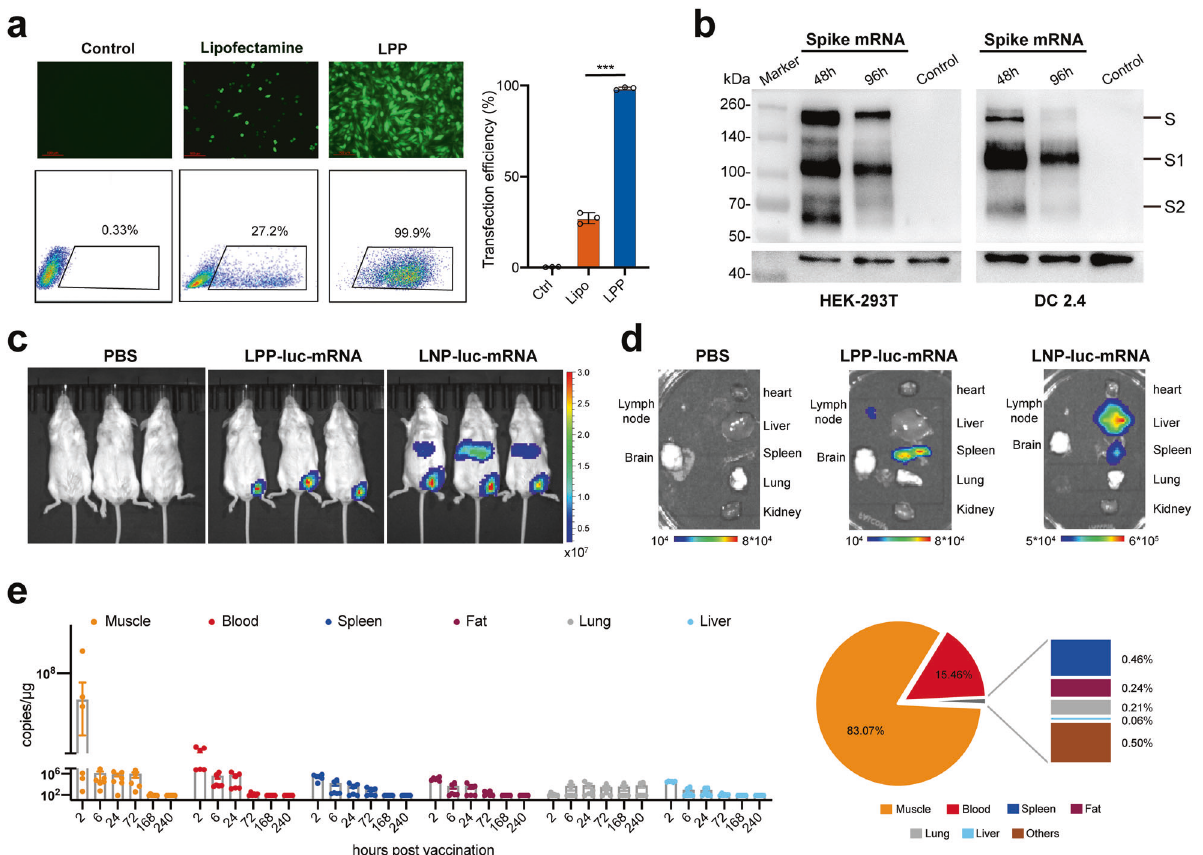
Fig. 2 Transfection ef fi ciency and biodistribution of LPP-mRNA. a eGFP-mRNA was transfected into DC2.4 cells using LPP or lipofectamine. Cells were harvested after 24 h of incubation. eGFP expression was visualized using fl uorescent microscope (upper panel) and quanti fi ed using fl ow cytometry (lower panel). b S protein expression from mRNA used for SW0123 preparation. mRNA encoding the S protein was transfected into HEK-293T and DC2.4 immortalized cells. Cells were harvested 48 and 96 h later, and S protein levels in cell lysate were detected with western blot. c Comparison of biodistribution between LPP/mRNA and LNP/mRNA. BALB/c mice were administrated intramuscularly (i.m.) with LPP or LNP encapsulated with luciferase-mRNA. Bioluminescence was measured 6 h later in a Xenogen IVIS-200 imaging system. d Mice were euthanized, and bioluminescent intensity in major organs were detected with a Xenogen IVIS-200 imaging system. e Biodistribution of SW0123 in BALB/c mice. BALB/c mice were i.m. injected with SW0123 at a single dose of 1.5 mg/kg. Major organs or tissues were collected at different time points following vaccination ( n = 6 mice each time point). mRNA concentration was determined with real-time qPCR using probes speci fi c for the mRNA component of SW0123 (left panel). Area under curve (AUC) representing accumulative distribution of SW0123 in each specimen is shown (right sites, which are major lymphoid organs where vaccine-speci fi c adaptive responses would be initiated (Fig. 2d). While in the LNP- mRNA group, signals were largely detected in the liver, which was in accordance with previous report. 23 These different biodistribu- tion patterns between LPP-mRNA and LNP-mRNA were most likely, due to their different particle size and lipid composition. Next, we investigated the kinetic biodistribution of SW0123. Following a single dose (1.5 mg/kg) i.m. administration into hind leg, multiple organs, or tissues were dissected and analyzed with quantitative PCR to quantify the mRNA component of SW0123. Bioluminescent signals were dominantly restricted to the injection sites with the highest signals detected at 2 h of post-injection (Fig. 2e, left). The rest of inoculated SW0123 was mainly distributed in blood circulation. Only a minor proportion was detected in the liver, which was in line with the aforementioned observation using mRNA encoding luciferase as a model molecule. Accumulative distribution of mRNA over a 10-day duration was also determined, and 83% of the inoculated dose of SW0123 was retained at the injection site (muscle). A proportion (15.5%) of SW0123 was found in the blood, and the remaining minority were distributed to multiple tissues including spleen (0.46%), fat (0.24%), and lung (0.21%). Only 0.06% was detected in the liver, recon fi rming the